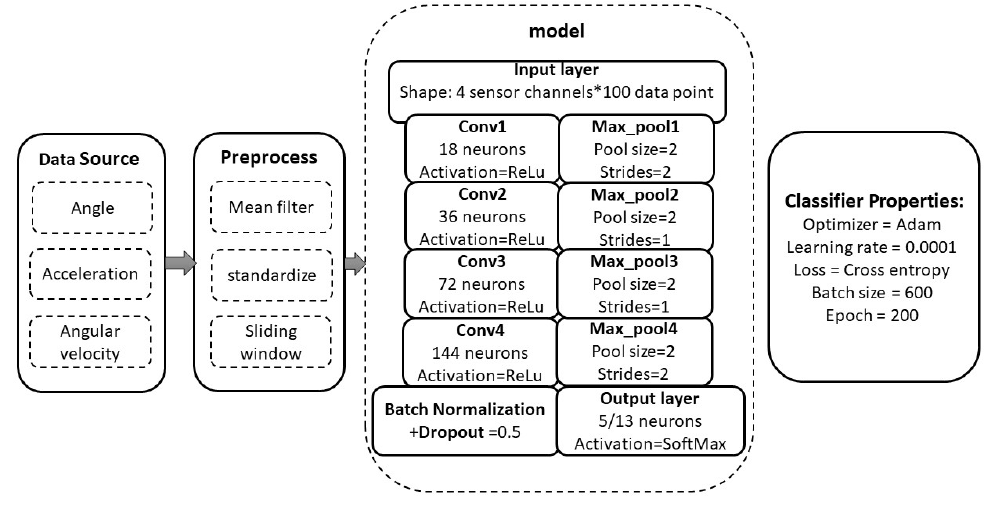
Figure 7. The structure of the motion recognition method with historical information based on deep